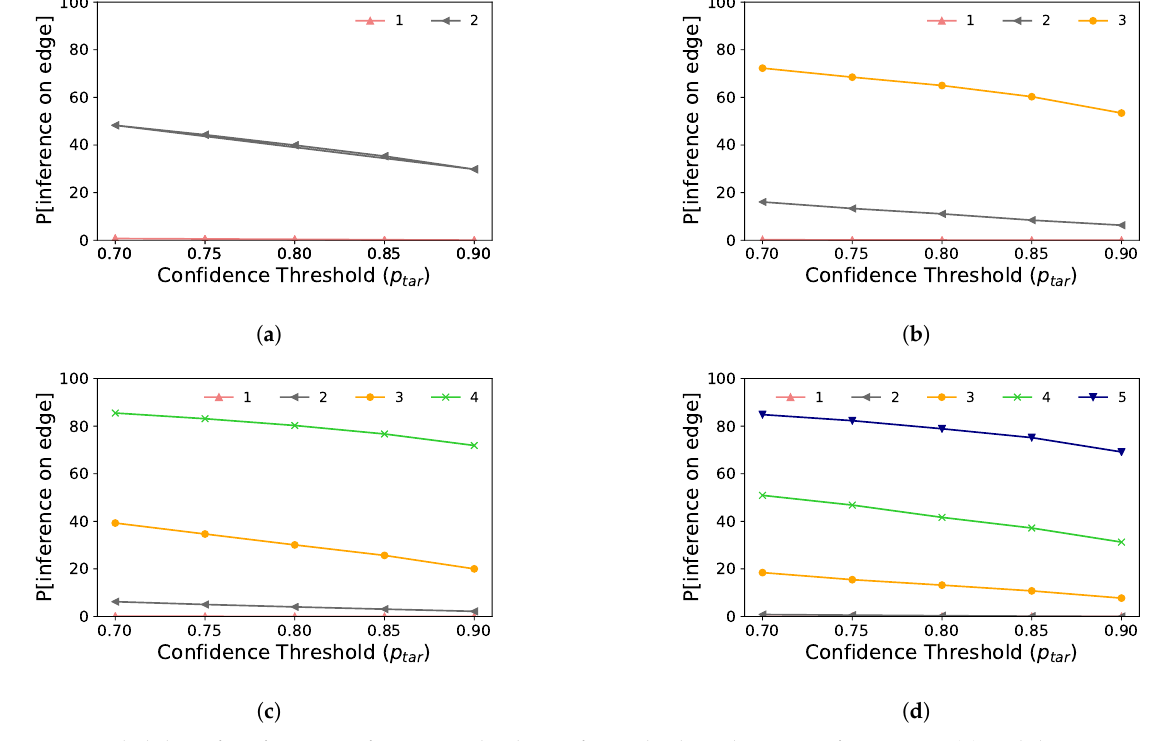
Figure 4. Probability of performing inference on the device for multiple early-exit configurations. ( a ) MobileNetV2 trained with 2 side branches. ( b ) MobileNetV2 trained with 3 side branches. ( c ) MobileNetV2 trained with 4 side branches. ( d ) MobileNetV2 trained with 5 side